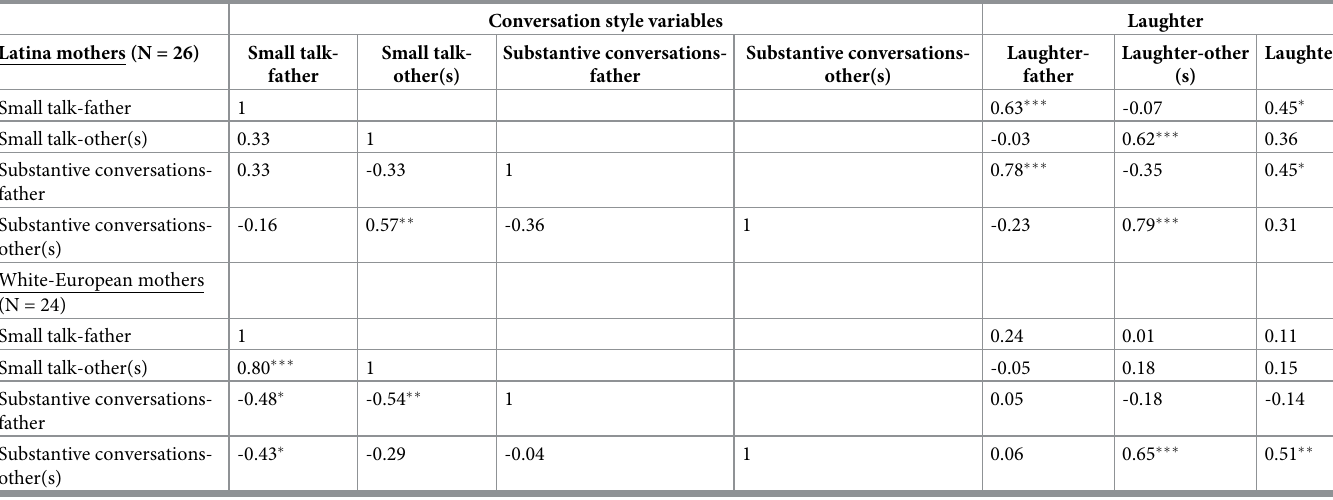
Table 3. Correlations between conversation style variables and laughter for both Latina and White-European